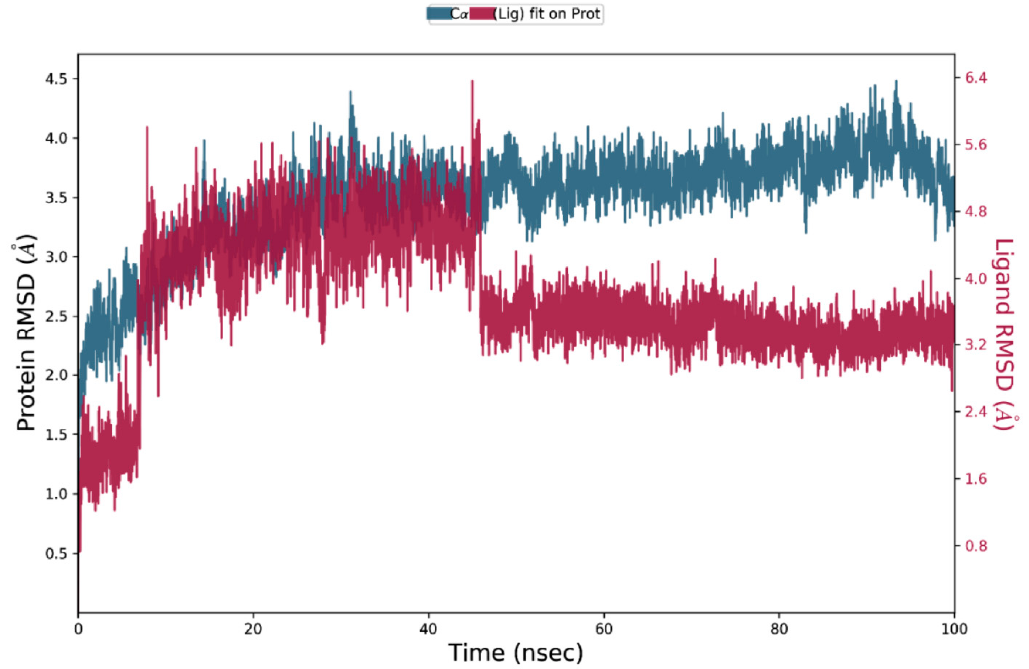
Figure 5. Root-mean-square deviation plot of C-alpha of beta-sitasterol in complex with 6IE9at 100 ns depicting the quality of the pose with respect to time.